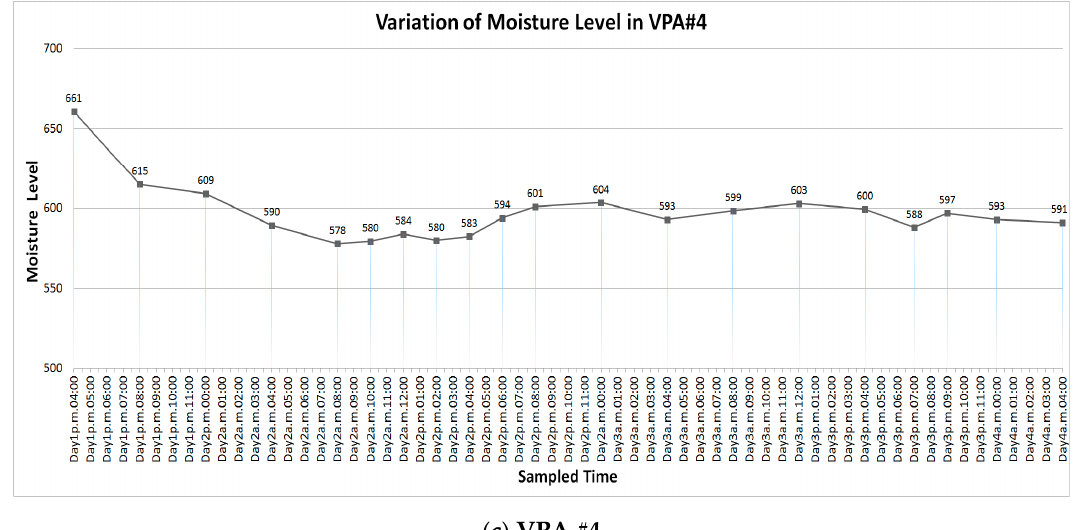
Figure 10. The moisture levels of the sensors at the 3 cm depth layer in different VPA. The moisture level is ranged from 0 to 1023. ( a ) the moisture level of the VPA#0. This VPA is located at the corner of the experimental plot. Similar VPAs are VPA#2, VPA#6, and VPA#8. ( b ) the moisture level of the VPA#1. Similar VPAs are VPA#3, VPA#5, and VPA#7. ( c ) the moisture level of the VPA#4, which is at the center location of the experimental plot.